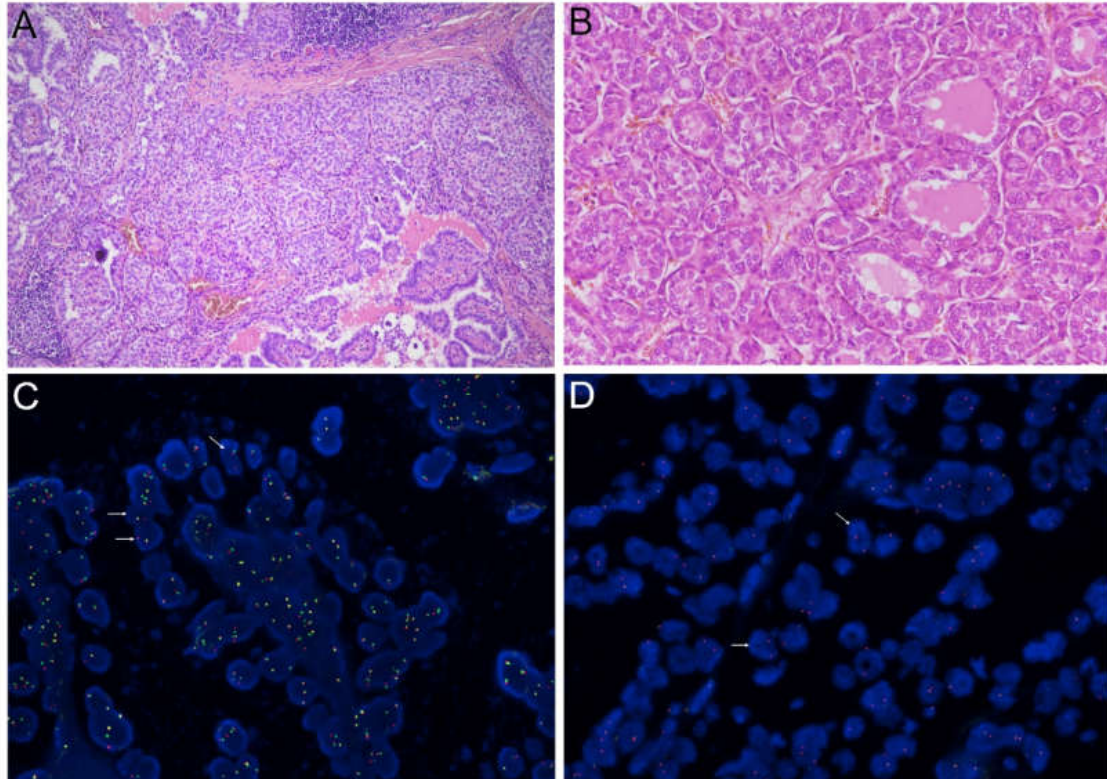
Figure 2. Microscopic images showing histological details and FISH analysis of two PTCs. ( A ) C-PTC with solid areas positive for NTRK3 fusion (hematoxylin and eosin staining, original magnification 10 × ); ( B ) detail of follicular growth areas of an ALK -positive C-PTC (hematoxylin and eosin staining, original magnification 20 × ); corresponding FISH analyses of NTRK3 and ALK are shown in ( C ) and ( D ), respectively. White arrows indicate examples of positive nuclei.